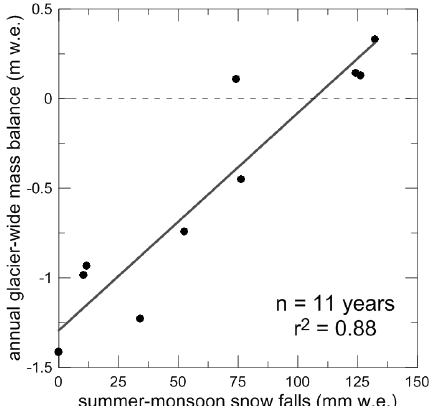
Figure 14. Annual glacier-wide mass balance as a function of the sum of the three largest summer-monsoon daily snowfalls assessed from precipitation record from Bhuntar meteorological station (see text for details) between 2002 and